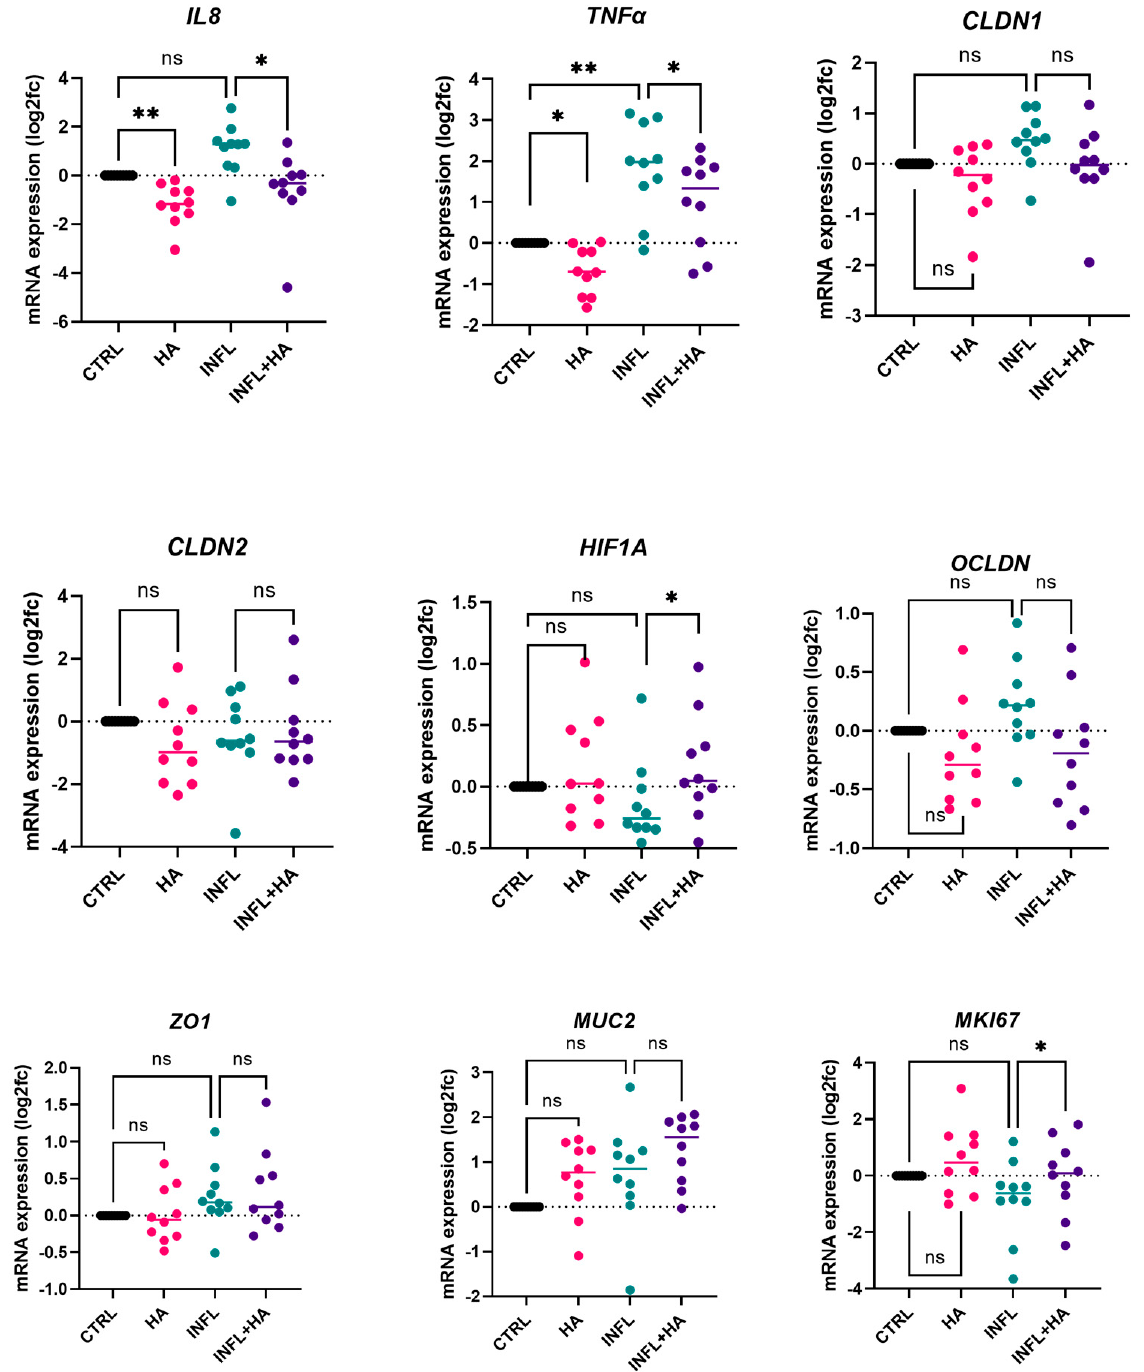
Figure 2. mRNA expression levels at 48 h ( n = 10) given by log2fold changes (log2fc) compared to the control condition, results of One-way ANOVA or Friedman tests are given (* p < 0.05; ** p < 0.01; ns = not significant). CTRL = Control medium, INFL = Control medium and inflammatory mix, HA = medium containing 100 mM acetate, INFL + HA = medium containing 100 mM acetate and inflammatory mix.